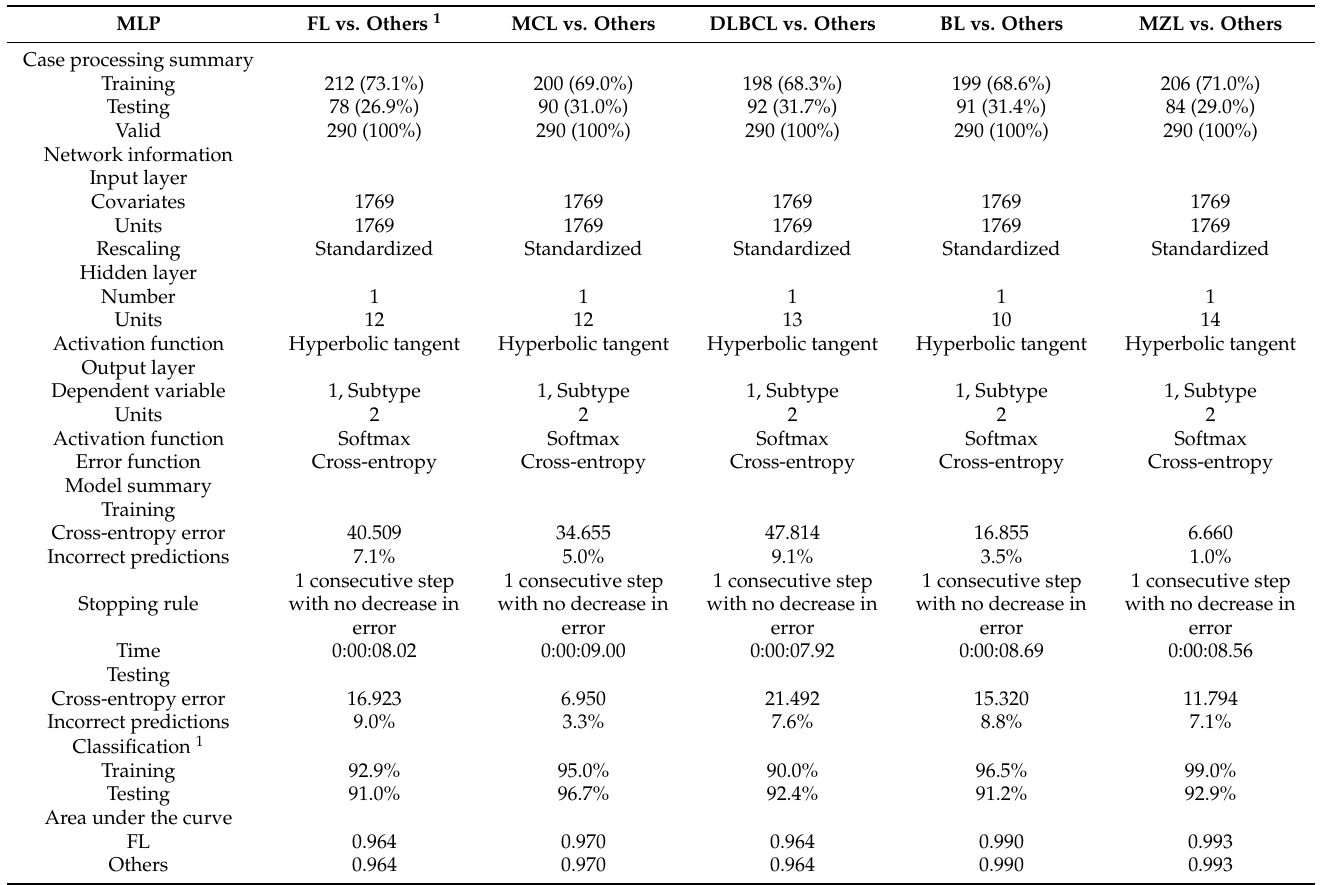
Table 5. Prediction of each NHL subtype by the cancer transcriptome panel ( n = 1769) using MLP analysis. MLP FL vs. Others 1 MCL vs.